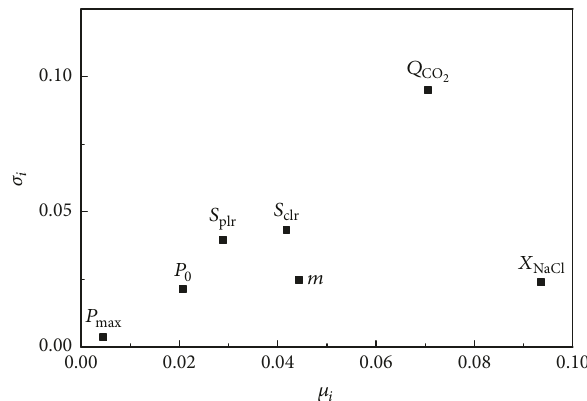
Figure 11: Morris global sensitivity analysis of 𝑆 𝑠 near the injection